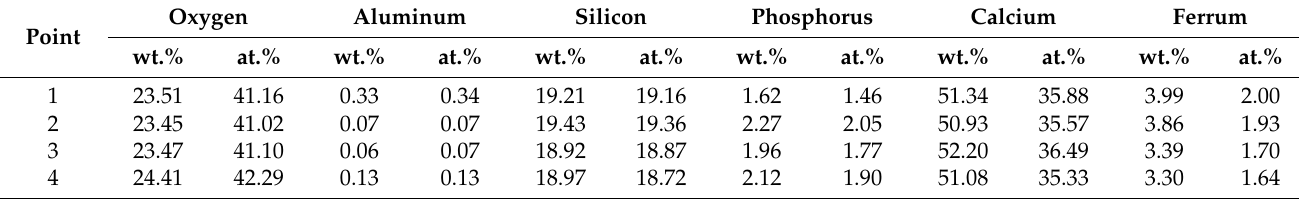
Figure 8. Analysis of the C 2 S–C 3 P solid solution by optical microscopy: ( a ) Visual field 1; ( b ) Surfaces of the generated solid solution layer of visual field 1; ( c ) Visual field 2; ( d ) Surfaces of the generated solid solution layer of visual field 2; ( e ) Height distribution of visual field 2. Table 2. Element analysis of four points in Figure